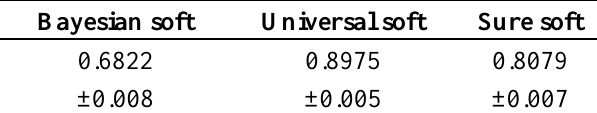
Table 1. The RMSEs for data including 1 abrupt and 1 gradual event over 1024 data points as in Figure